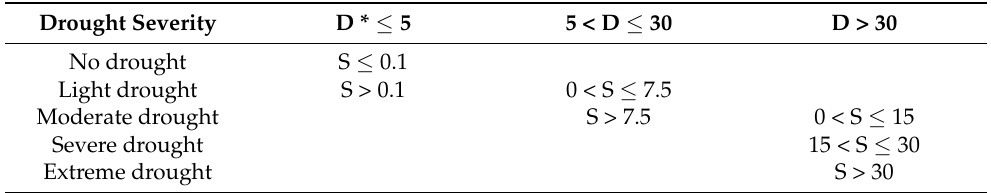
Table 2. Probability density function and parameters of different probability distributions.